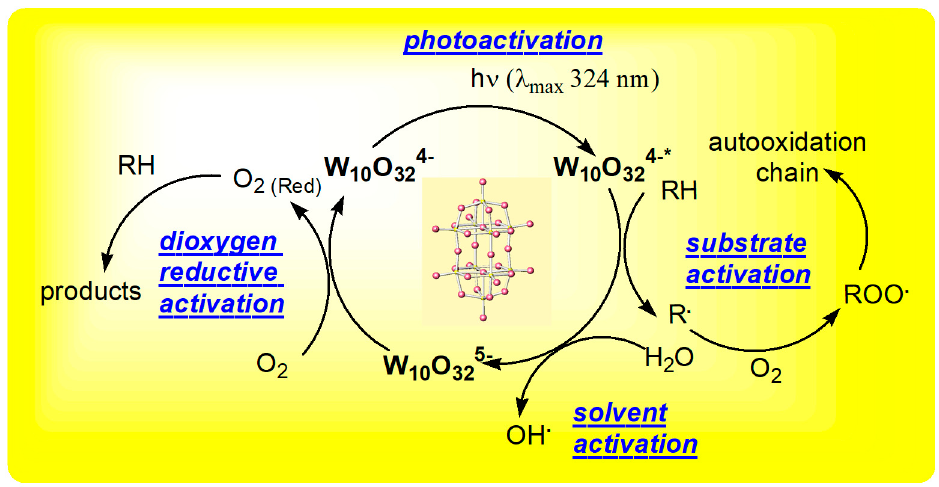
Figure 6. Schematization of the decatungstate-promoted photocatalysis in water [87].